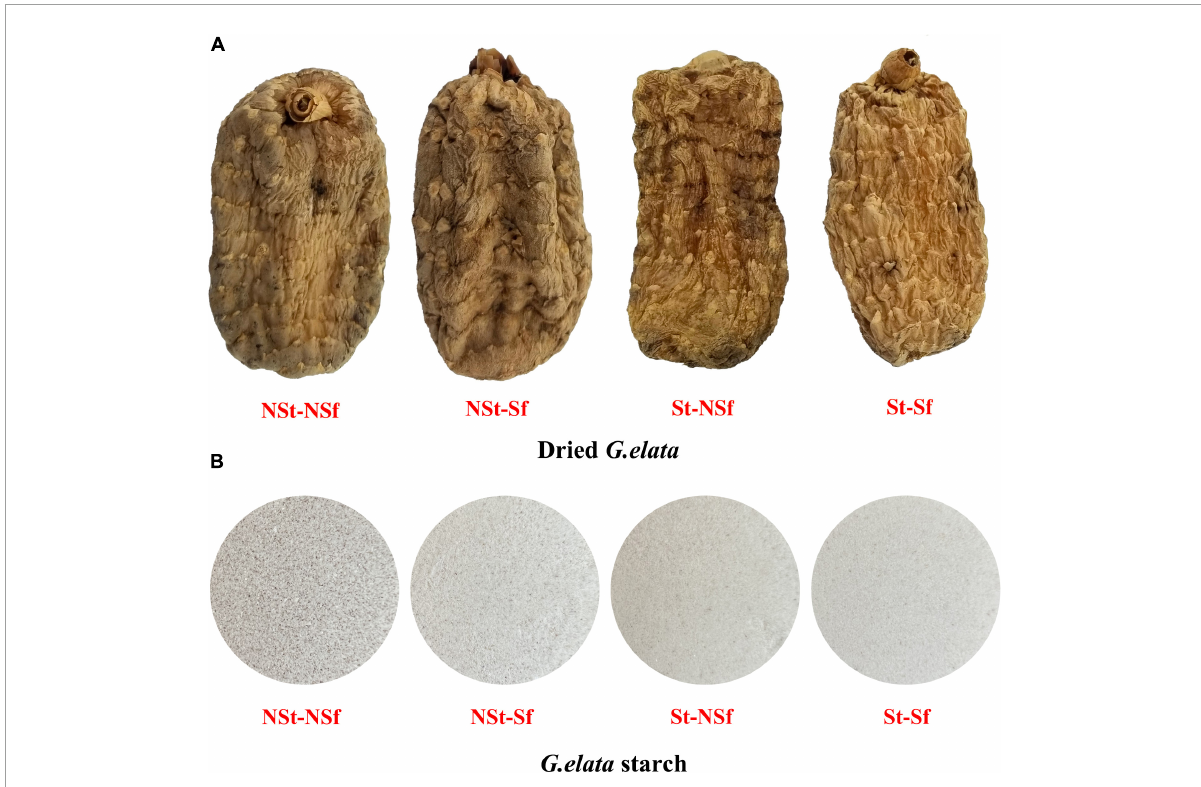
FIGURE3 Effects of steaming and sulfur fumigation treatment on the morphology of Gastrodia elata and starch (A,B)